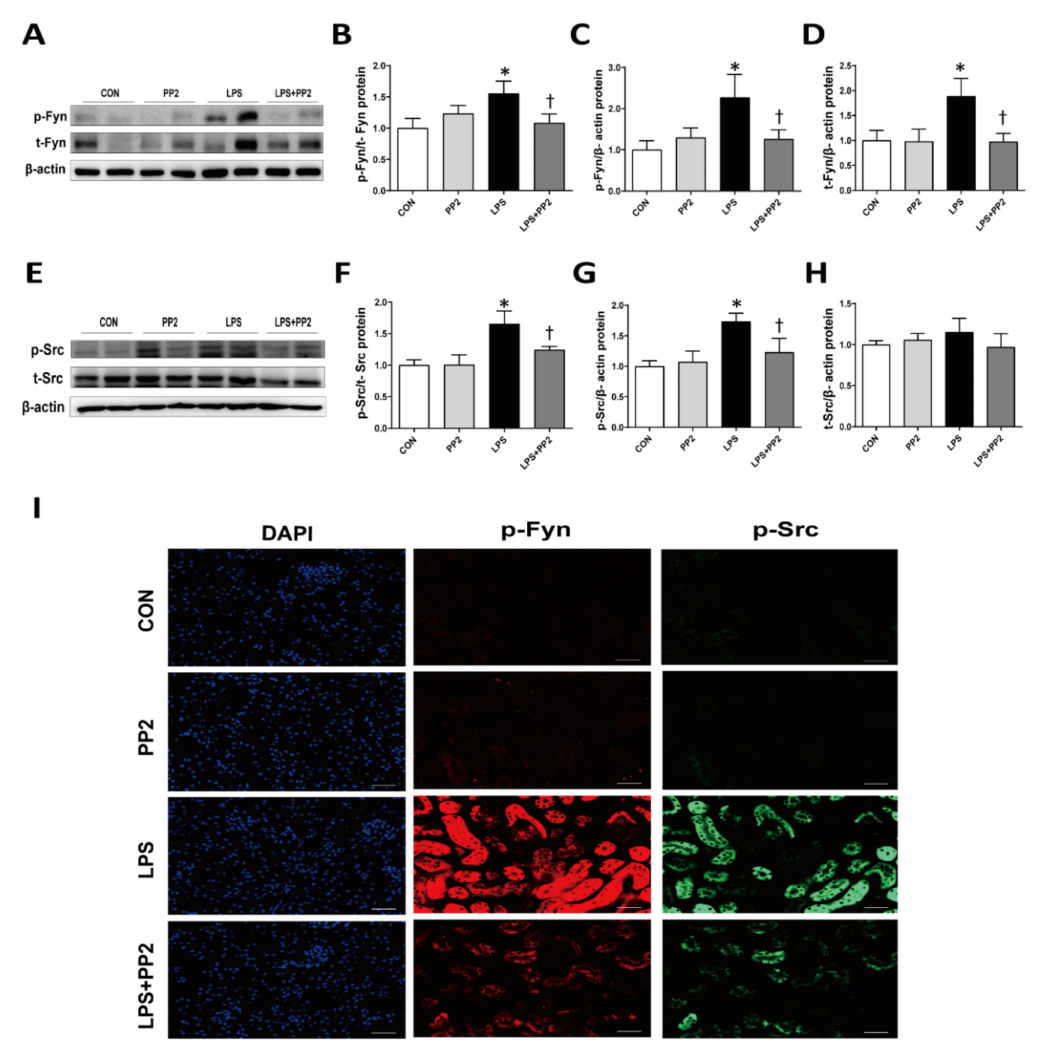
Figure 6. PP2 inhibits Src and Fyn kinase expression in LPS-induced AKI mice. Six-week-old male C57 / BL6 mice were pretreated with PP2 (2 mg / kg) for 2 h and then administered LPS (15 mg / kg) for 18 h. ( A – H ) Immunoblotting analysis of phosphorylated / total Fyn and Src kinase in the kidney. Levels of proteins were normalized to their respective total protein. ( I ) Kidney sections were subjected for immunofluorescence staining with phospho-Fyn (red) and phospho-Src (green) antibodies and 4’,6-diamidino-2-phenylindole (DAPI; blue). Data are presented as mean ± SE of 6–8 mice. * p < 0.05 vs. control, † p < 0.05 vs.